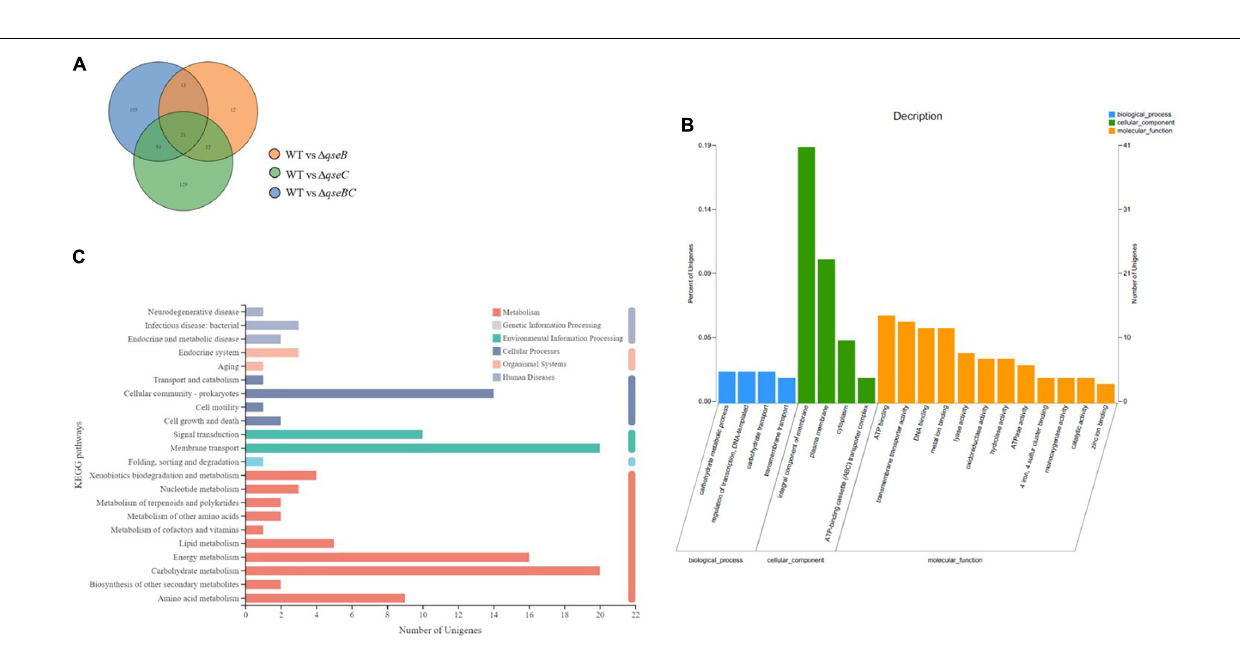
Frontiers in Microbiology |